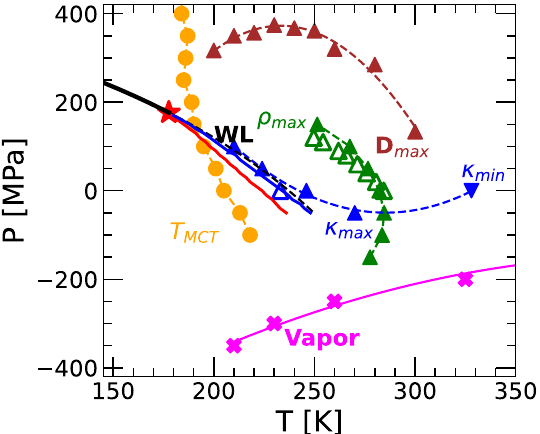
Figure 8. Same as Fig. 7 for the case of D 2 O. Results are from PIMD/RPMD simulations using the q-TIP4P/F water model. The empty green-up triangles are experimental maxima densities from Ref. 81 . The empty blue-up triangle is the isothermal compressibility maxima from Ref. 5 . The estimated location of the LLCP based on experiments is ( T c = 230 K, P c = 50 MPa) 50